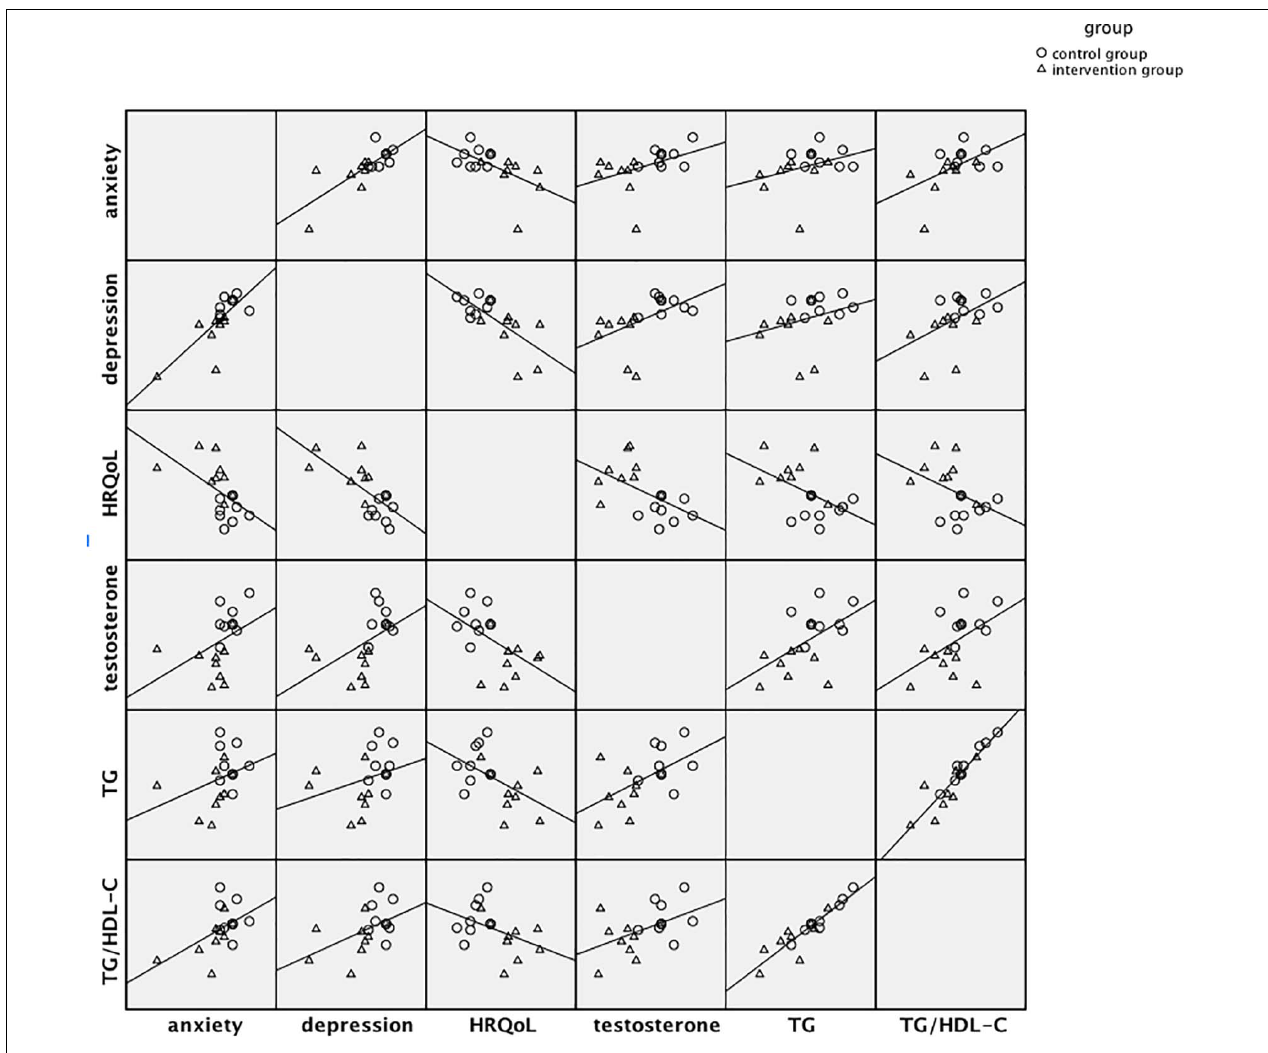
FIGURE 2 | Scatterplot matrix of associations between standardized residuals of pre-post changes in major mental and physical